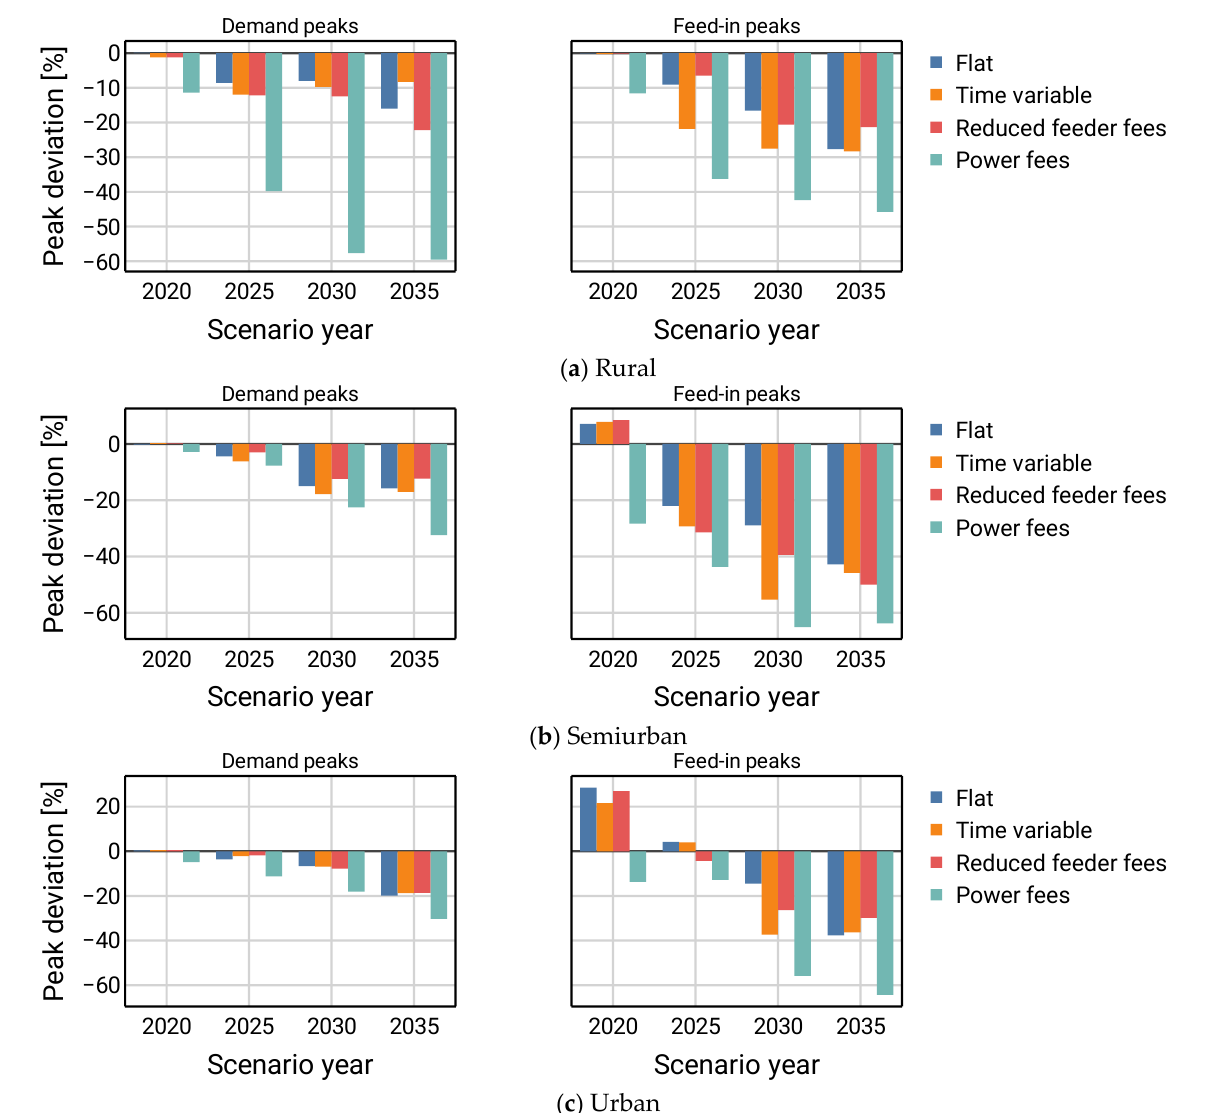
Figure 9. Relative deviation of demand and feed-in peaks for a variation of grid types ( a – c ) and scenario years and grid tariff designs. Deviation calculated using the 5% highest daily peaks of the business-as-usual scenario.